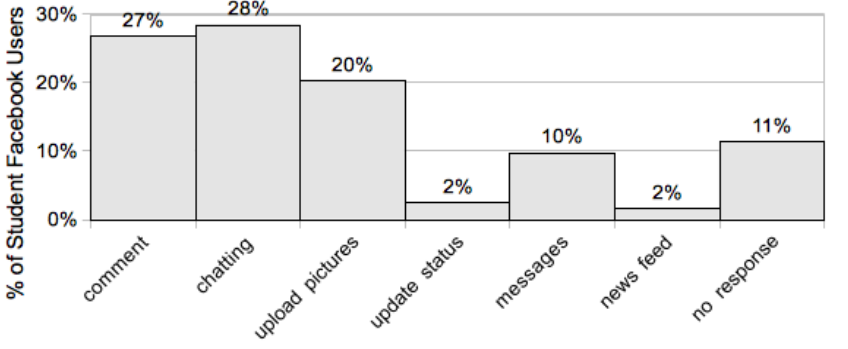
Figure 10 . Students' favorite Facebook features. Note: data are exclusive.